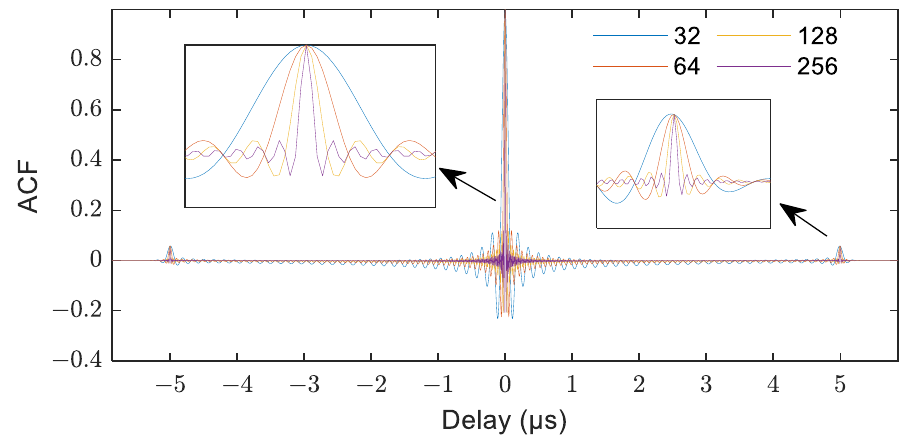
Figure 3. The ACF of OFDM navigation signals with a different number of subcarriers.